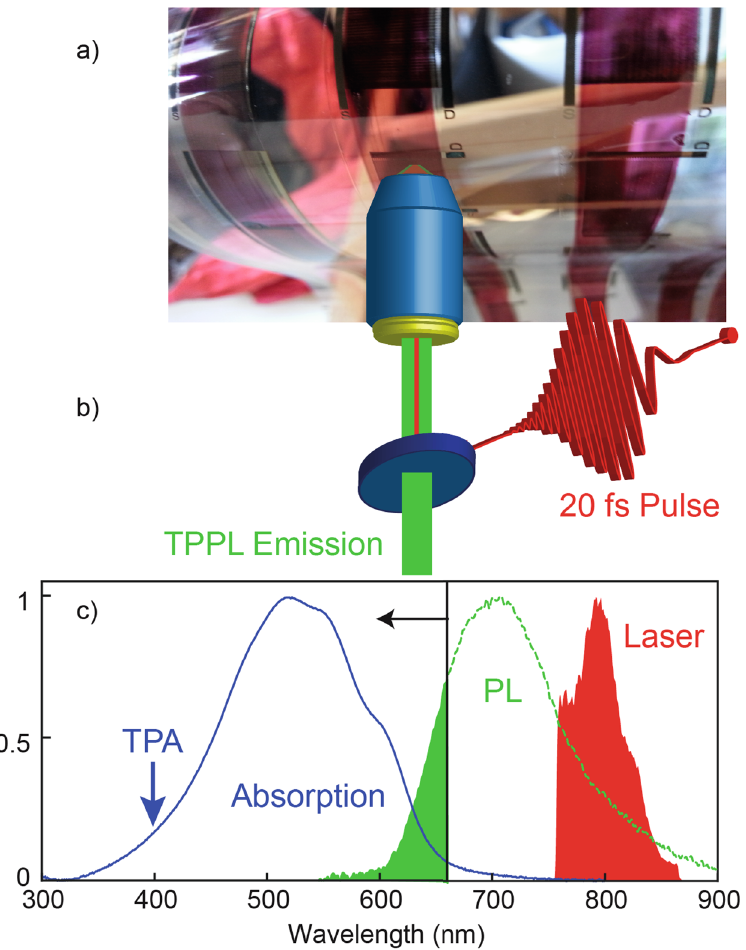
Figure 1. Non-linear optical characterization of a polymer semiconductor material roll coated on a flexible substrate. ( a ) Image of the flexible PET substrate with R2R printed source and drain silver electrodes covered by P3HT polymer semiconductor stripes. ( b ) Schematic of the non-linear optical microscope. ( c ) Absorption spectrum of P3HT (blue curve), emission spectrum of P3HT (green curve) and excitation laser spectrum (red coloured region). The green coloured region represents the amount of photoluminescence from P3HT detected in the experiment, considering that a 670 nm short pass filter is used. The blue arrow represents the effective wavelength at which the two-photon absorption occurs.